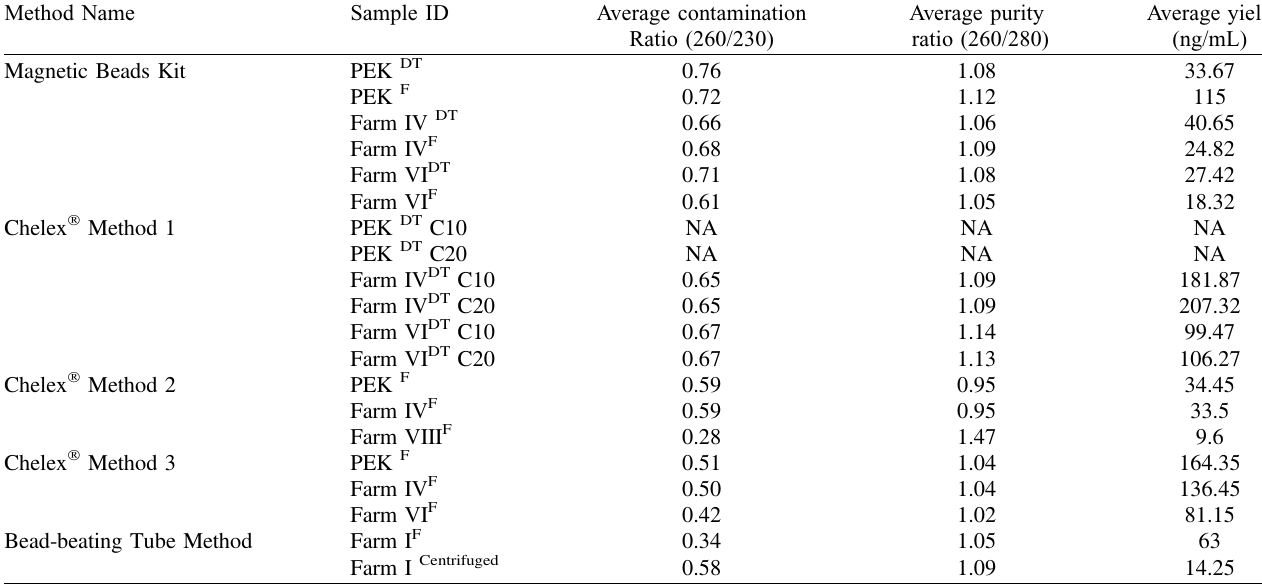
Fig. 3. Validation of the colourimetric LAMP assay by the ITS2 PCR. A: Gel-electrophoresis image of PCR amplicons. Ladder used: 100 bp ladder. B: Corresponding LAMP results. P: Positive control. N: Non-template control. I-X: Farm I-X. DF: Farm DF. GF: Farm GF. Yellow/Orange = Positive/Weak Positive, Pink/Purple = Negative. Table 4. DNA measurements for the supplementary DNA extraction